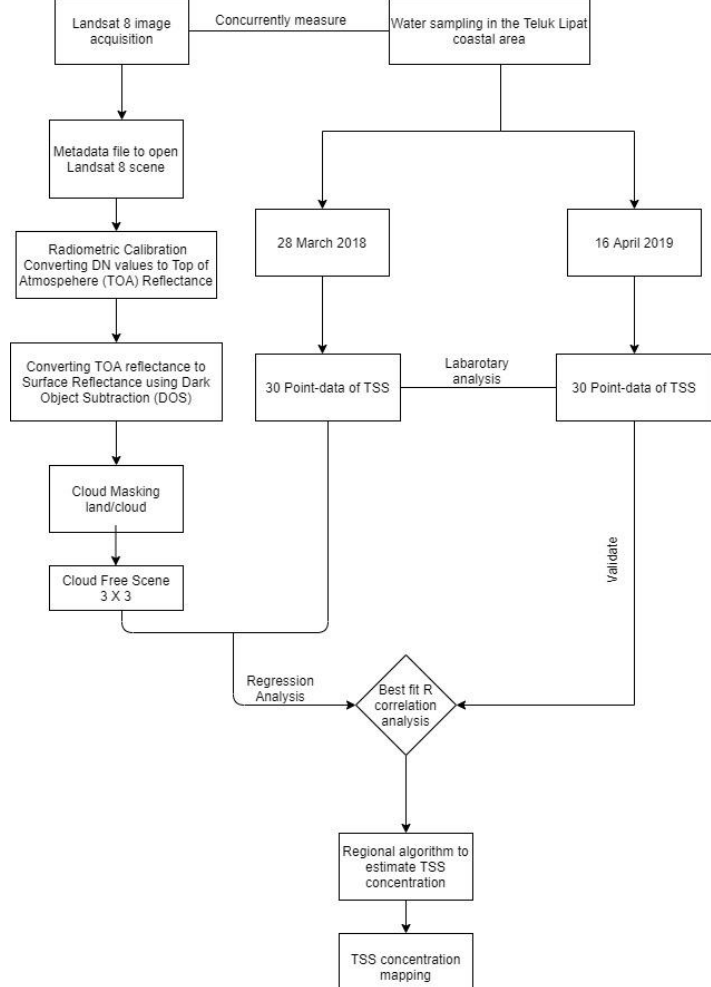
Figure 2. Data processing flowchart.